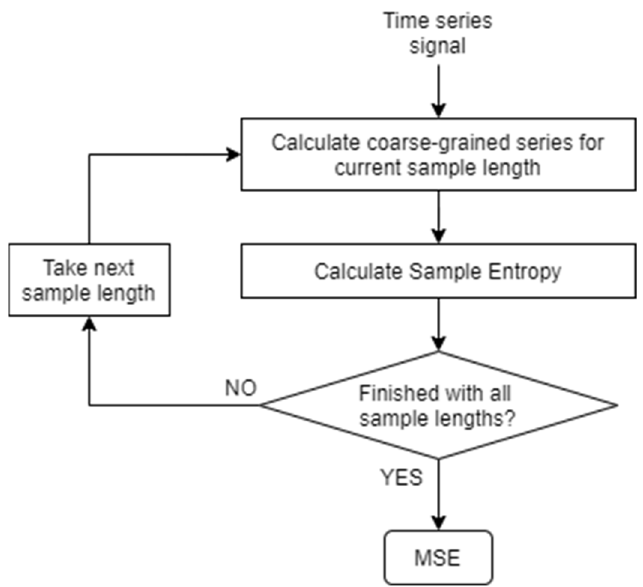
Figure 2. Steps required for calculating MSE from a given time series.